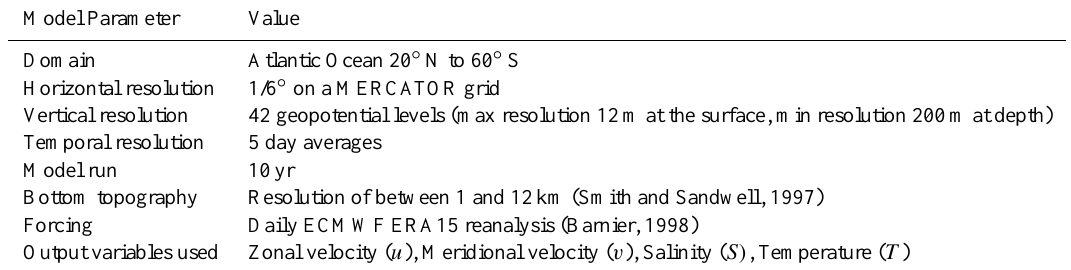
Fig. 8. Theoretical sections. (a) Standard linear theory, (b) mean flow with a flat bottom, (c) no mean flow with topography and (d) mean flow and topography. Contour interval is 0.05. Table 1. Specifics of the CLIPPER model configuration used to generate the